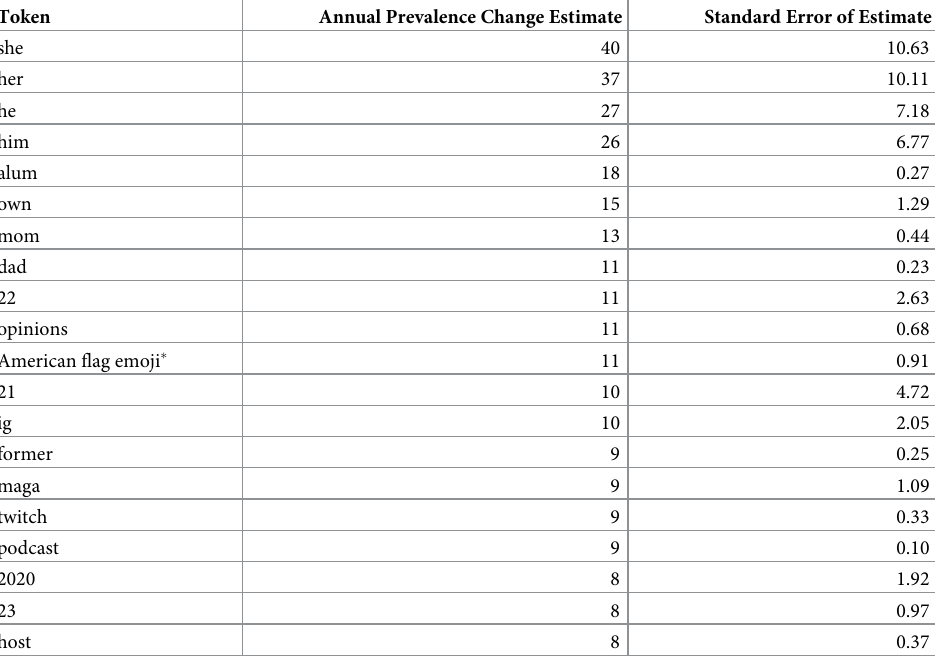
Table 4. Top 20 winner tokens in the longitudinal